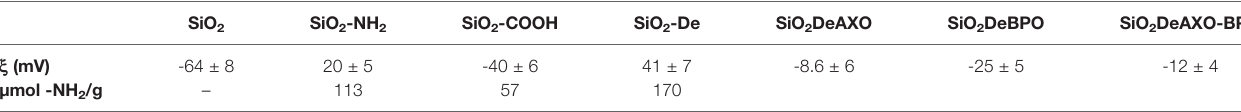
TABLE 2 | Ninhydrin test and Zeta potential of the functionalized silica particles. SiO